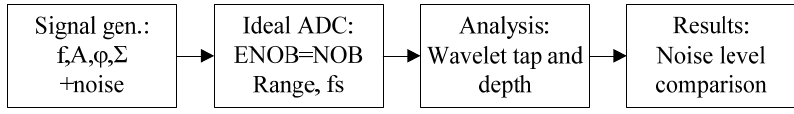
Figure 1. Block diagram of simulation system.